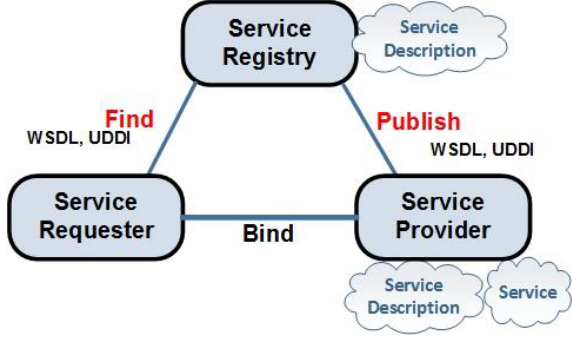
Fig. 1. Basic Service-oriented Architecture